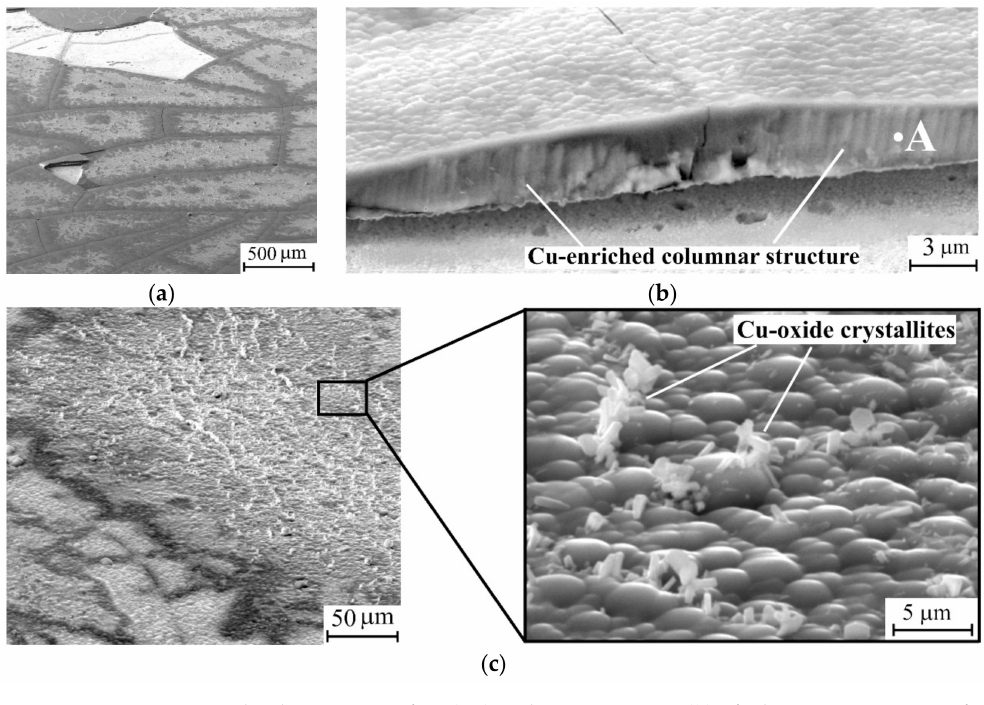
Figure 5. SEM micrographs showing a surface ( a , c ) and a cross-section ( b ) of Al 0.11 Si 0.89 N coating after 1 thermal cycle.